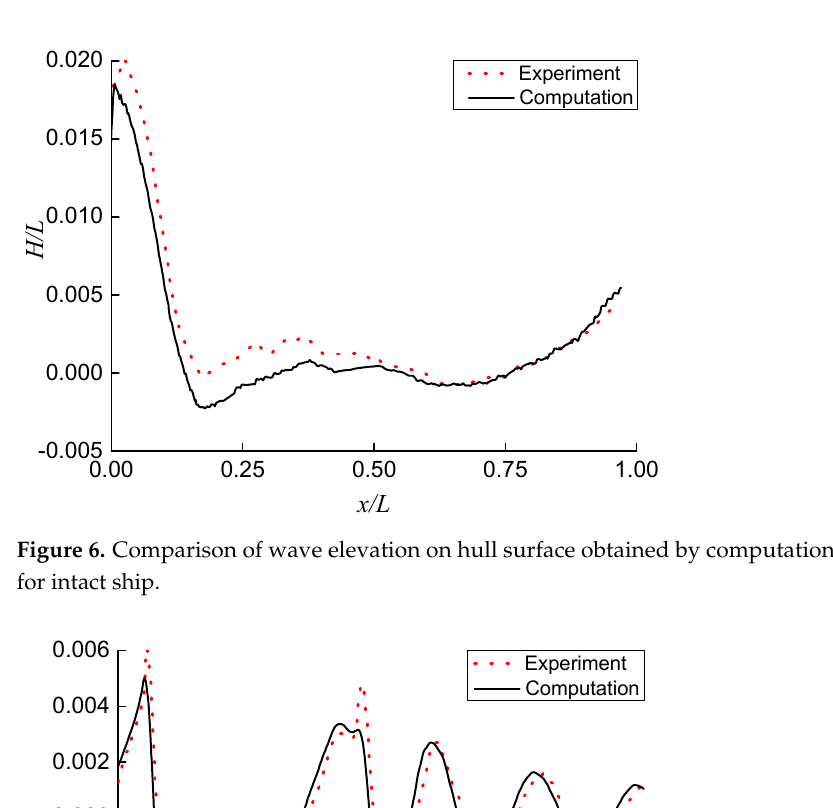
Table 5. Results of grid dependence study for intact ship ( Fr = 0.28).